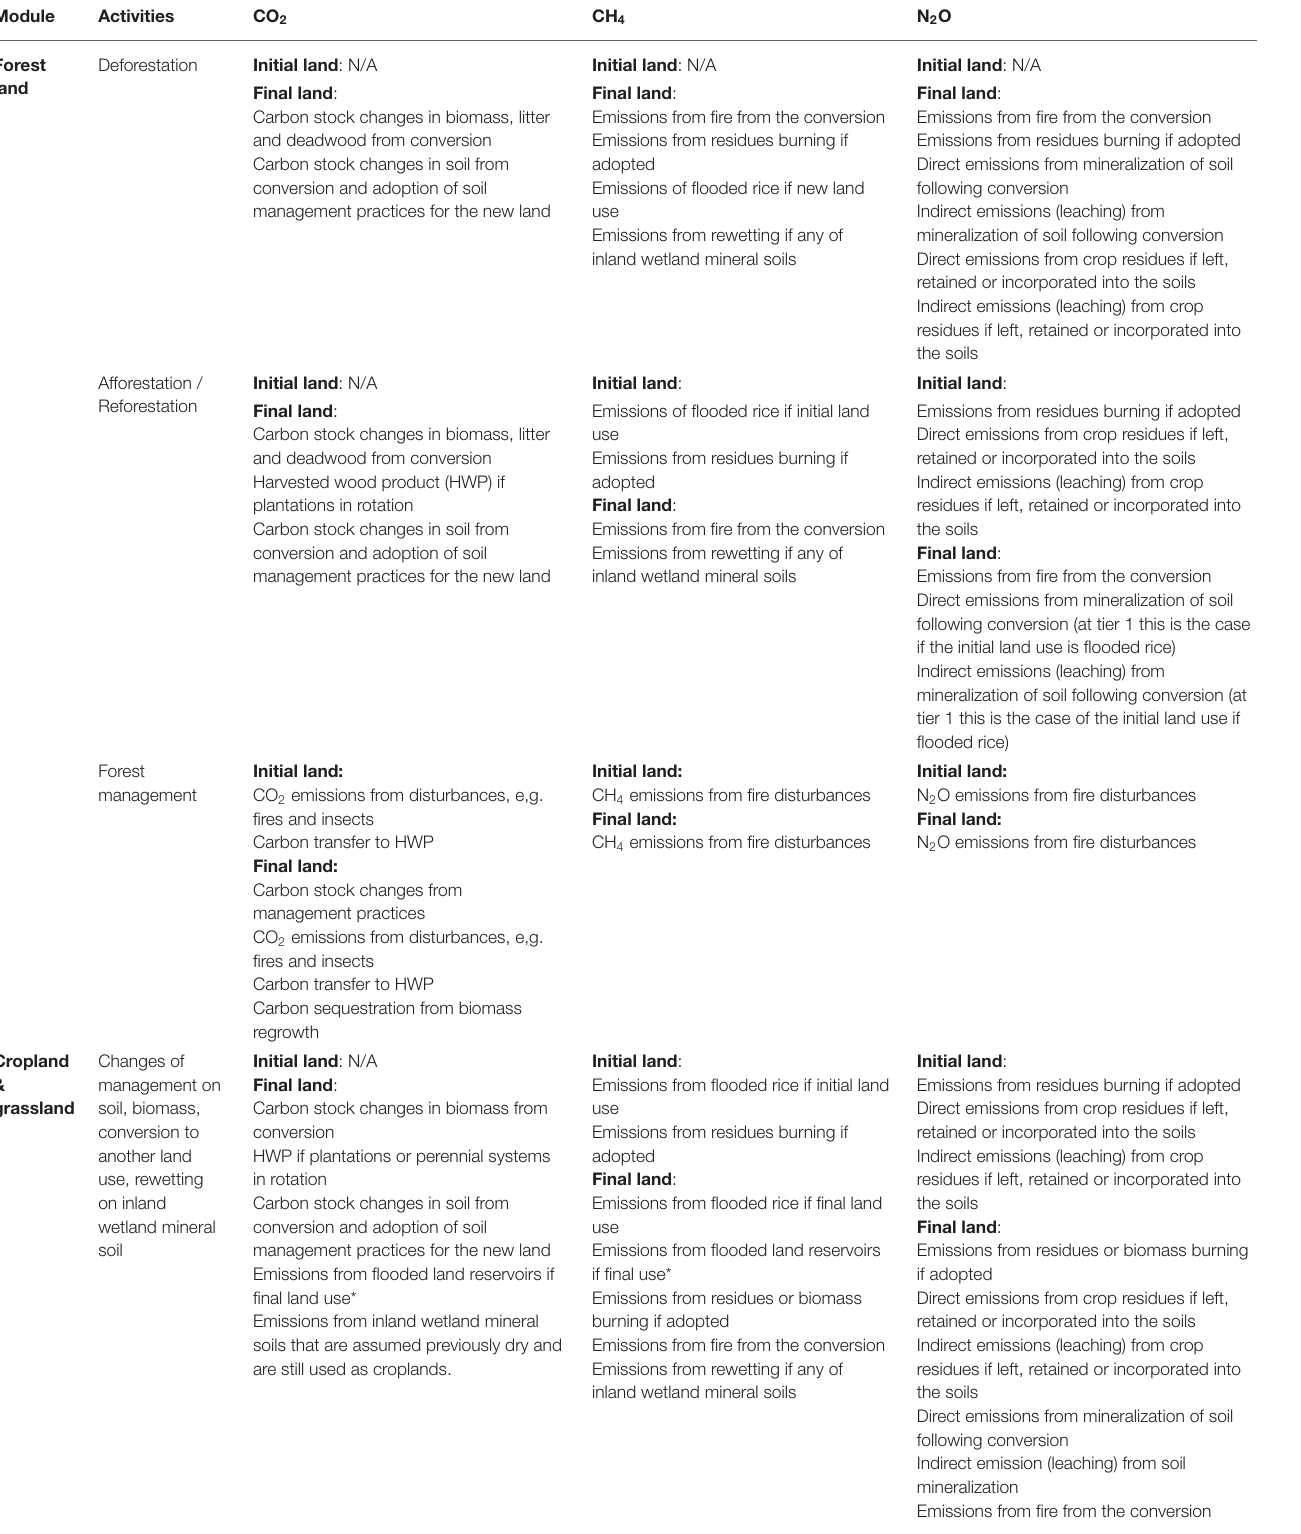
TABLE 3 | Mapping of the different greenhouse gas and their sources in the different NEXT modules. Module